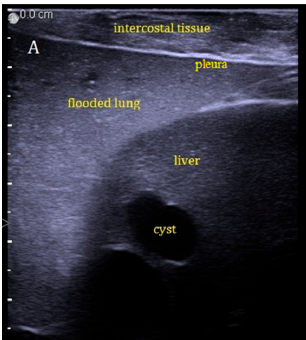
Figure 4. Sonographic imaging during OLF in-vivo with clear visualization of hyperechoic lung, well demarked from hypoechoic liver. Appl. Sci. 2020 , 10 , x FOR PEER REVIEW